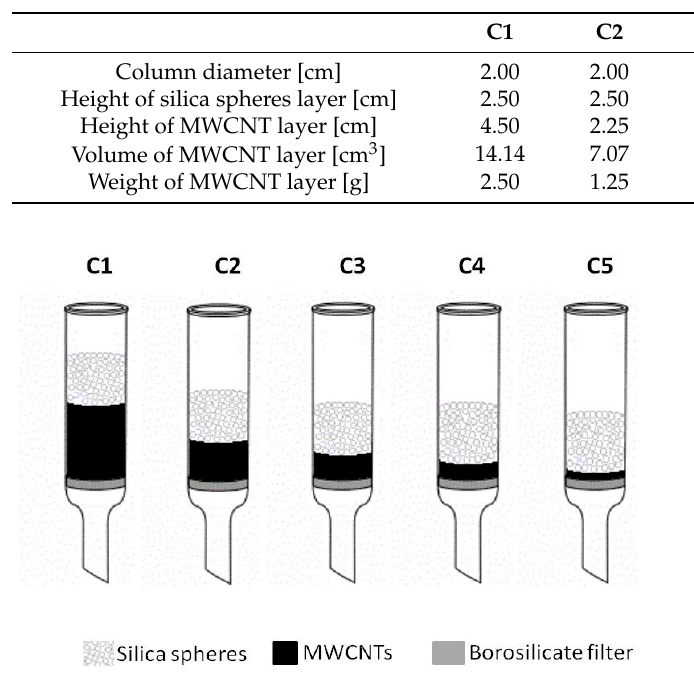
Figure 1. Schematic representation of the different adsorption columns.